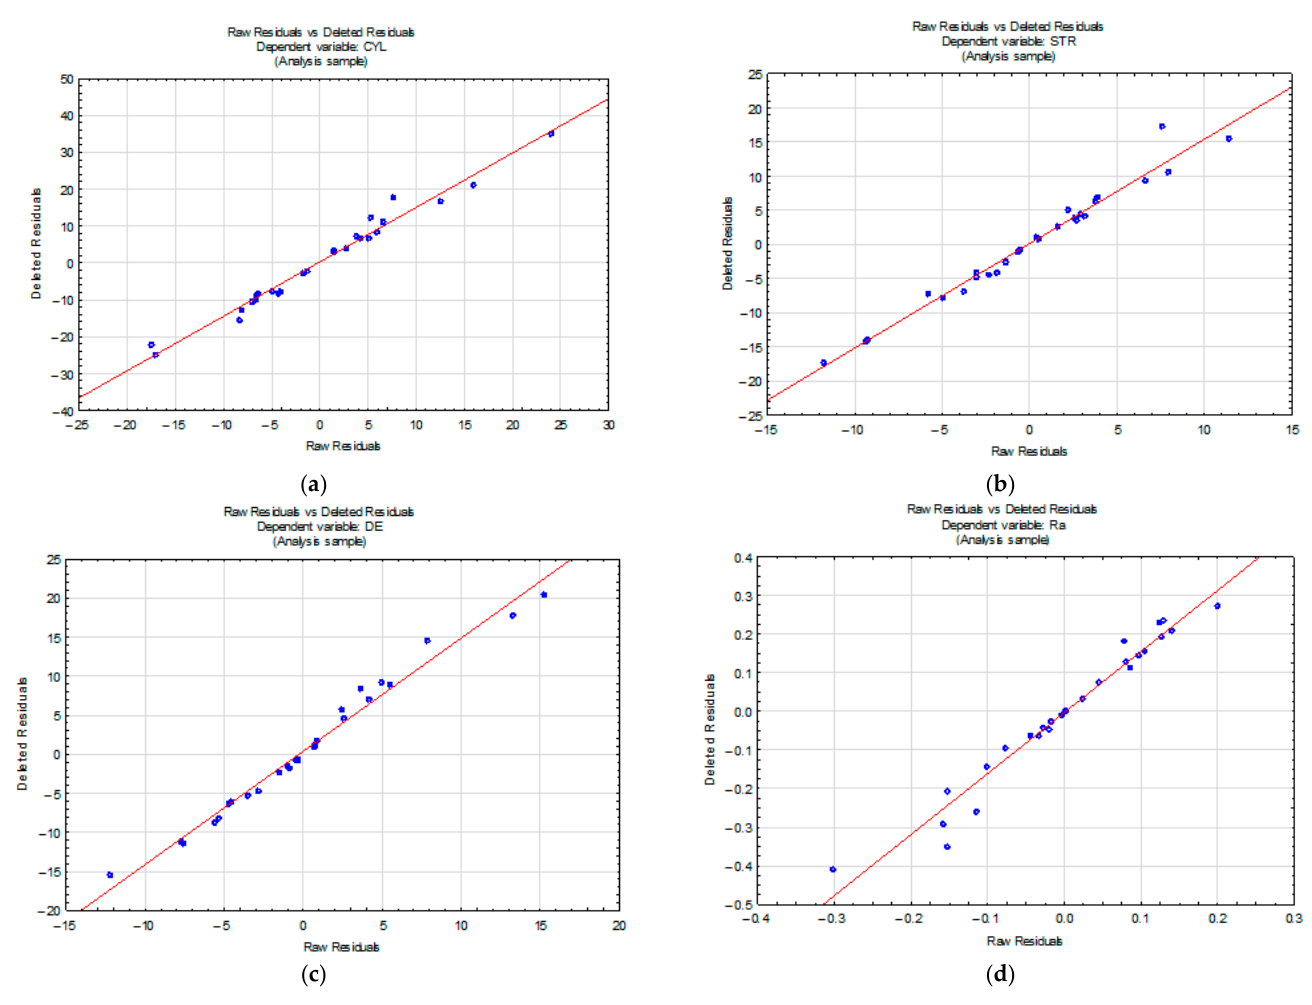
Figure 8. Normal probability plots for: ( a ) the cylindricity error; ( b ) the straightness error; ( c ) the diameter error; and ( d ) the parameter R a .